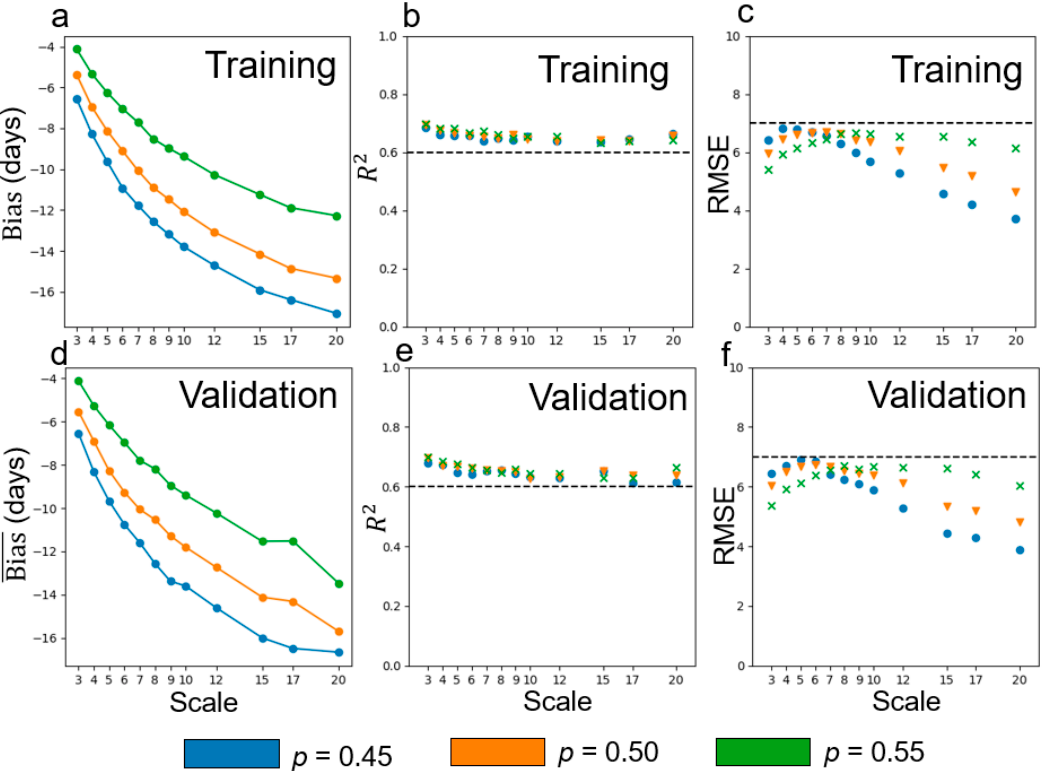
Figure 8. ( a , d ) The average of bias values change as the training and validation dataset scale (size of the aggregated window) changes; ( b – f ) Performance of the multi-endmember model at different scales for training and validation datasets in terms of the R 2 and root-mean-square error (RMSE, days) values.